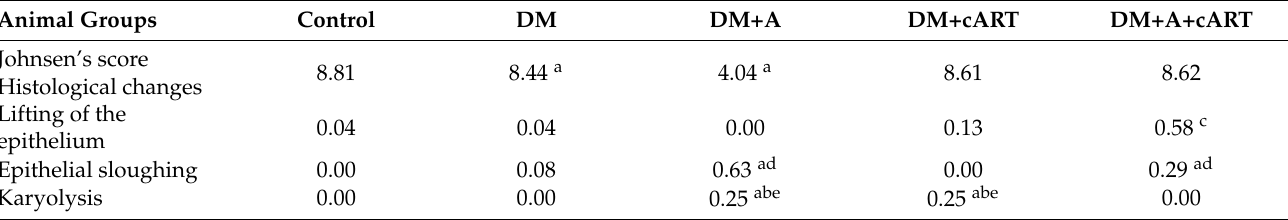
Table 3. Median Johnsen’s scores and histological changes observed in animal